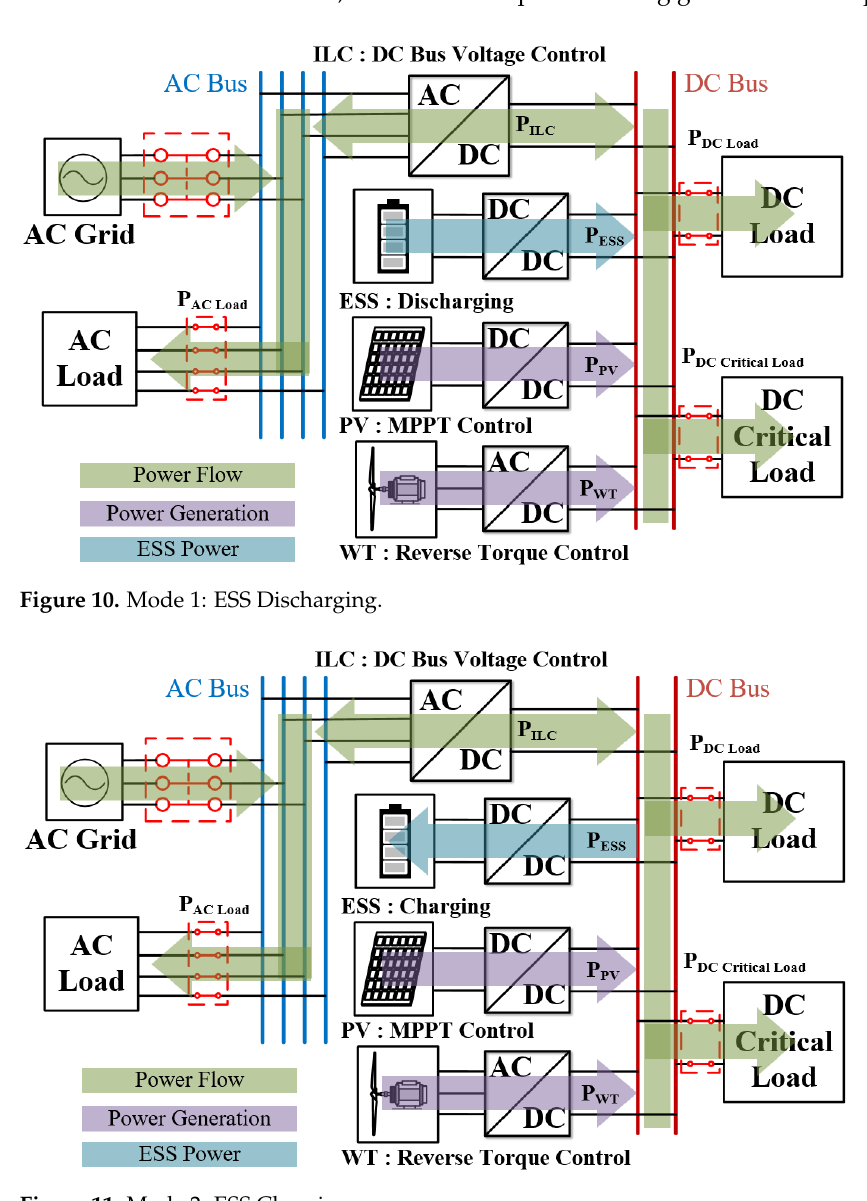
Figure 11. Mode 2: ESS Charging.